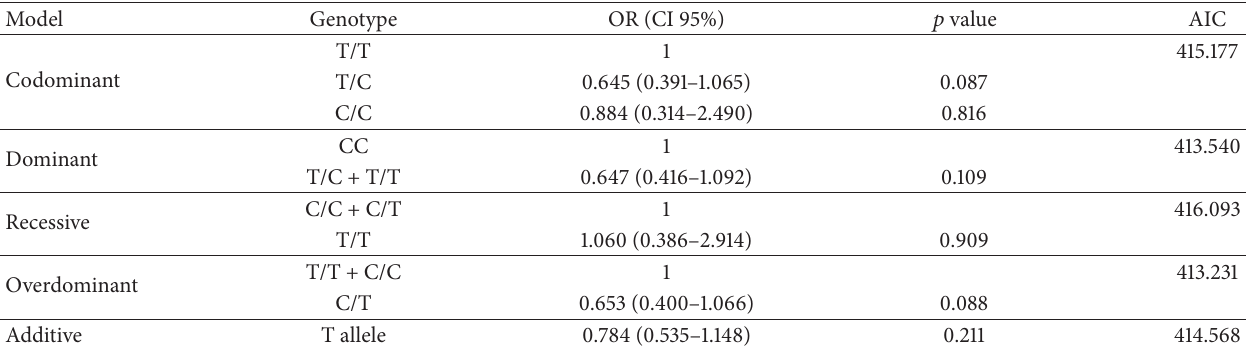
Table 4: Binomial logistic regression analysis in the patients with pituitary adenoma (PA) and in the control group.